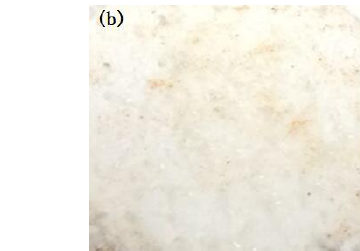
Table 1. The tensile strength of bonding interface between (PEG) 10 LiClO 4 and Al at room temperature.